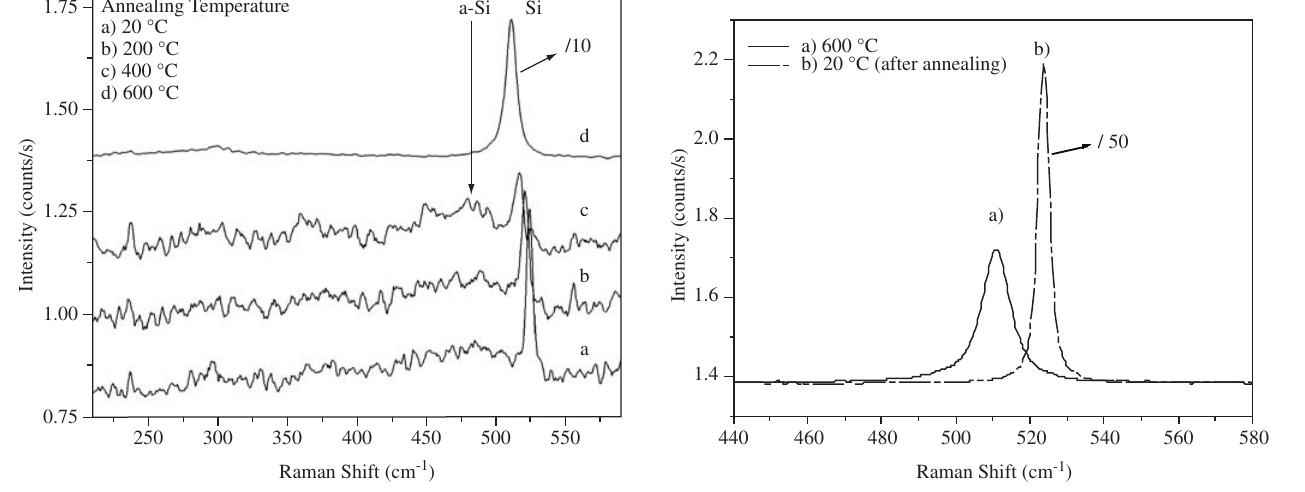
Figure 10. Raman spectra of the silicon (100): a) machined surface at at an- nealing temperature of 600 °C; b) machined surface after annealing at room temperature 20